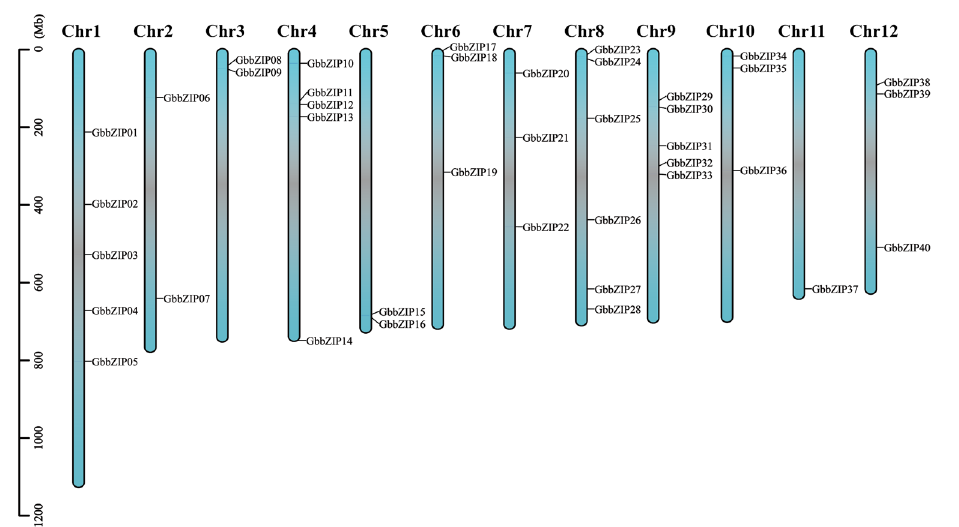
Figure 1. Visualization of GbbZIP family conserved domains in G. biloba . Alignment of GbbZIP conserved domains created using WebLogo program (http:// weblo go. three pluso ne. com/ create. cgi). The total height of the letter piles at each position indicates the conservation of the sequence at that position (measured in bits). The height of a single letter in the letter piles represents the relative frequency of the corresponding amino acid at that position.